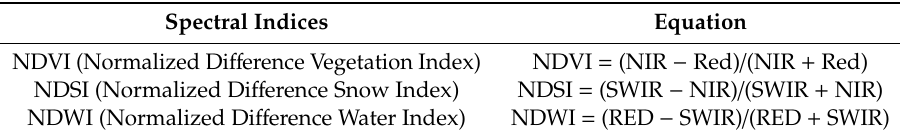
Table 1. Vegetation indices and their respective